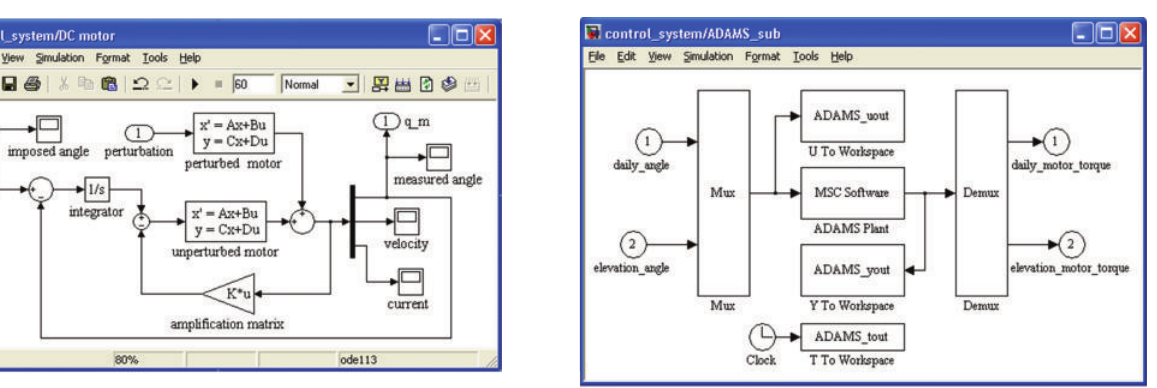
Figure 5: The block diagram of the DC motor.